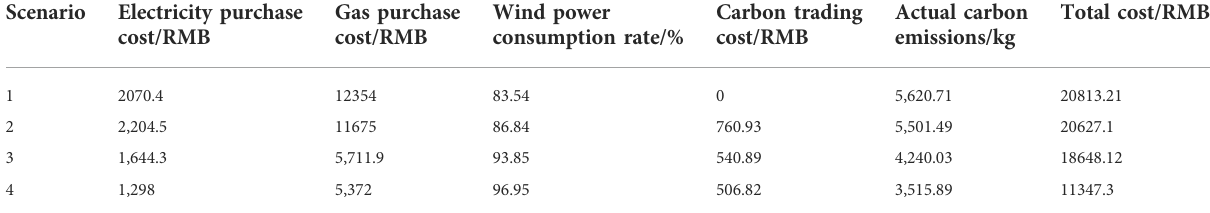
TABLE 3 Comparison of the results of scenarios 1, 2, 3, and 4. Scenario